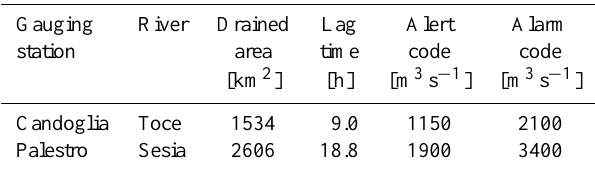
Table 1. Main characteristics of the catchments involved in the ana-